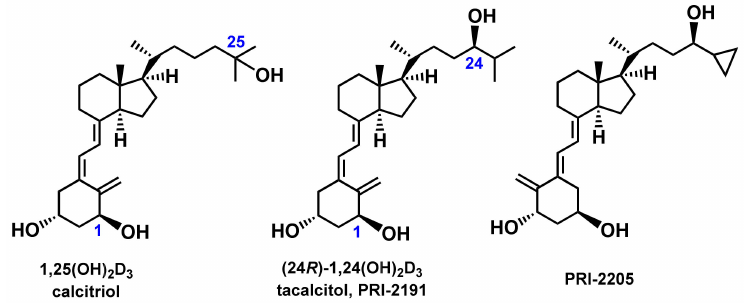
Figure 1. Structures of vitamin D